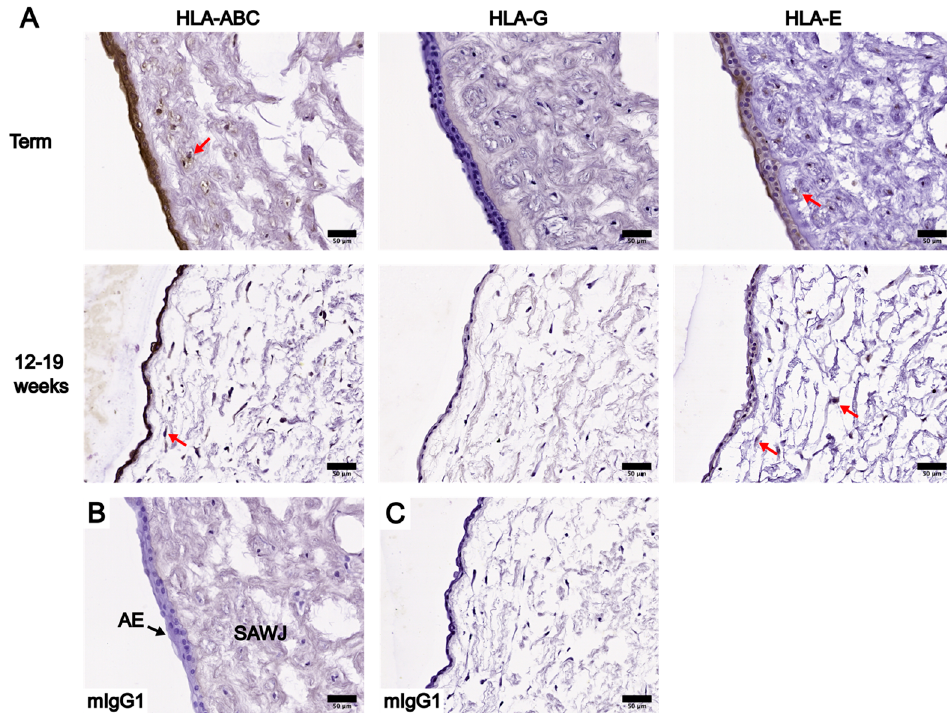
Figure 3. Comparison of IHC staining results of HLA-ABC, HLA-G, and HLA-E in whole UC cross-sections at term and between 12 and 19 weeks, focusing on the AE and SAWJ. ( A ) IHC staining results of UC cross-sections at term are shown in the first row, and IHC staining results of UC between 12 and 19 weeks are shown in the second row. Red arrows: examples of cells in the SAWJ showing positive staining for the corresponding HLA of interest. ( B ) Negative control of term UC IHC staining results using an anti-mIgG1 antibody. ( C ) Negative control of 12–19-week UC IHC staining results using an anti-mIgG1 antibody. Scale bars = 50 µm.